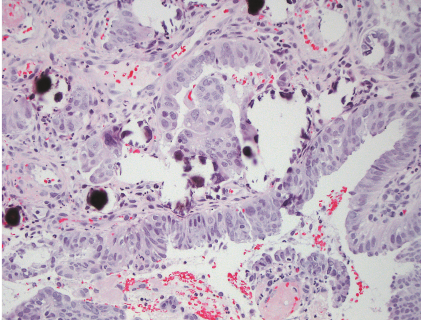
Figure 3: Cytokeratin 7 (CK7) typically stains positive (dark brown) in carcinomas of epithelial origin including endometrial cancer.